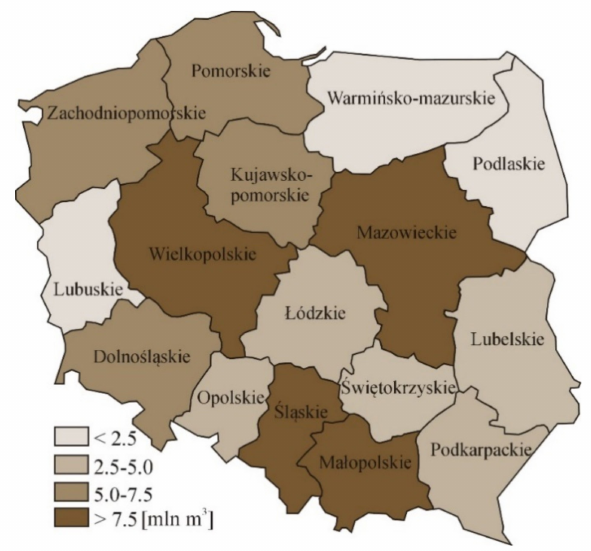
Figure 13. Volume of BM that can be obtained from sewage sludge in Poland (mln m 3